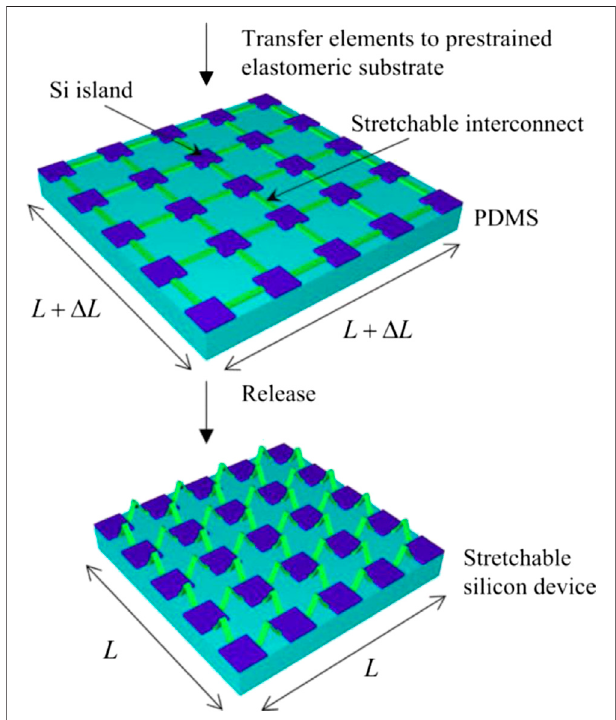
FIGURE 5 | Schematic illustration of the process for fabricating electronics with the island – interconnect mesh designs on an elastomeric substrate (Song et al., 2009). Reproduced with